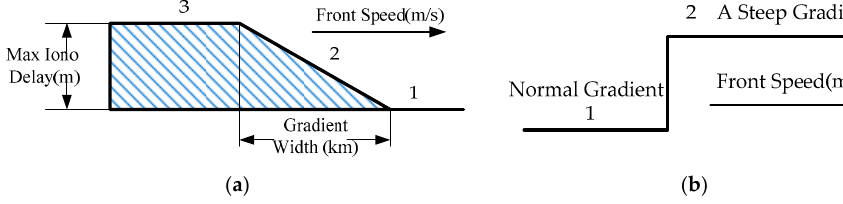
Figure 1. ( a ) Simplified model of the ionosphere anomaly; ( b ) simplified model of the ionosphere gradient anomaly.